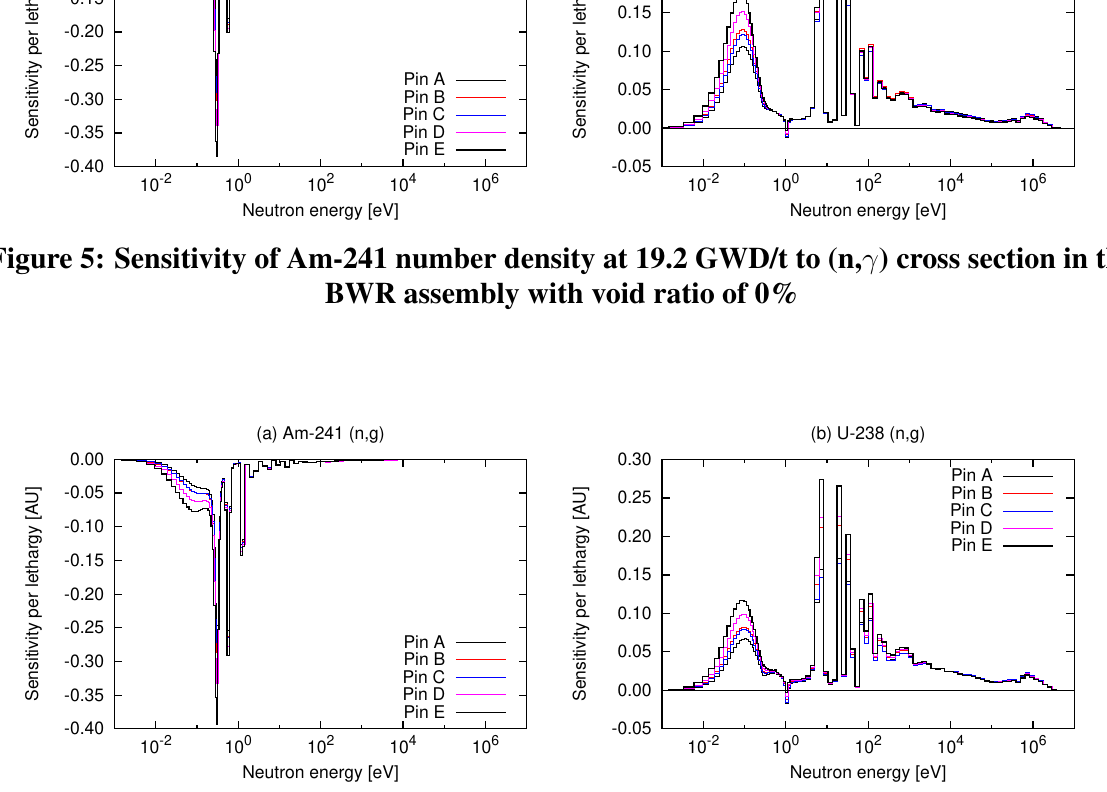
Figure 6: Sensitivity of Am-241 number density at 19.2 GWD/t to (n, γ ) cross section in the BWR assembly with void ratio of